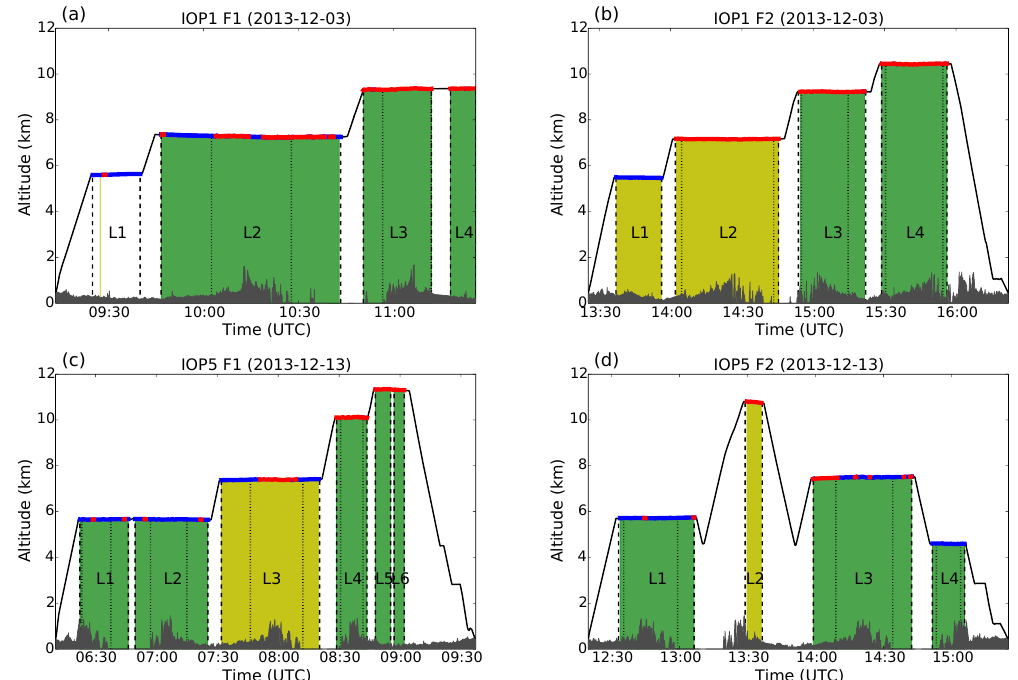
Figure 2. Flight legs and altitudes of the four research flights during (a, b) IOP1 and (c, d) IOP5. The yellow and green shaded areas indicate regions where the airborne lidar operated in scanning and nadir-pointing mode, respectively. Blue and red thick lines indicate respective flight altitudes below and above the tropopause, which was determined by in situ trace gas measurements of N 2 O with a threshold value of 326.6ppbv (see Sect. 2.2). The black dashed and dotted lines mark flight legs used for data analysis and indicate complete flight legs and leg sections limited to mountain regions, respectively. The topography along the flight tracks is based on the ASTER data